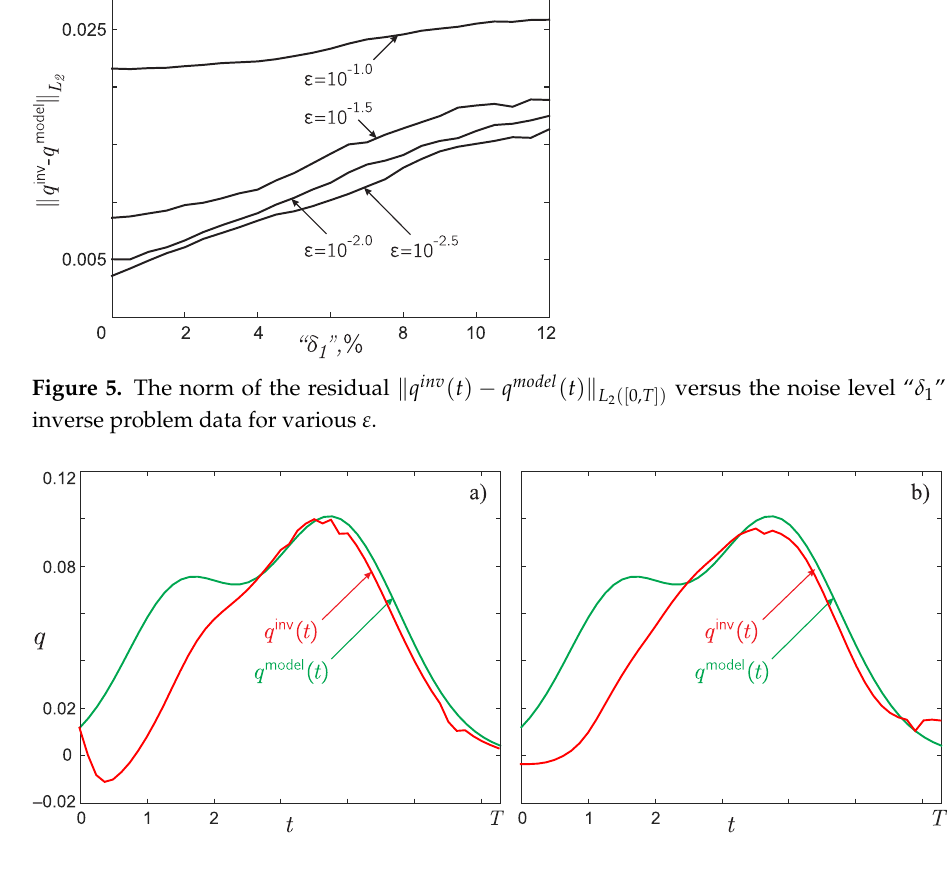
( t ) simulated for a set of δ 1